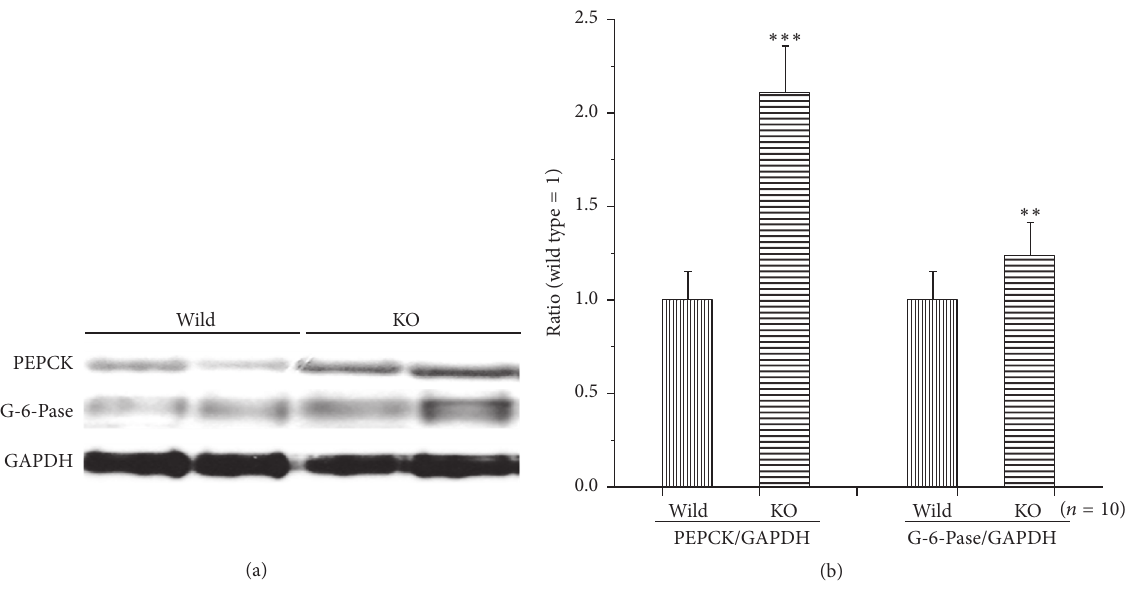
Figure 6: The levels of PEPCK and G6Pase in the liver of Mig-6 f/f and Mig-6 d/d mice. (a) Western blotting analysis with anti-PEPCK, anti- G6Pase, and anti-GAPDH antibodies in liver. ∗∗ and ∗∗∗ indicate 𝑃 < 0.01 and 𝑃 < 0.001 , versus wild mice, respectively. Data are presented as mean ± SE from 6 to 10 mice per